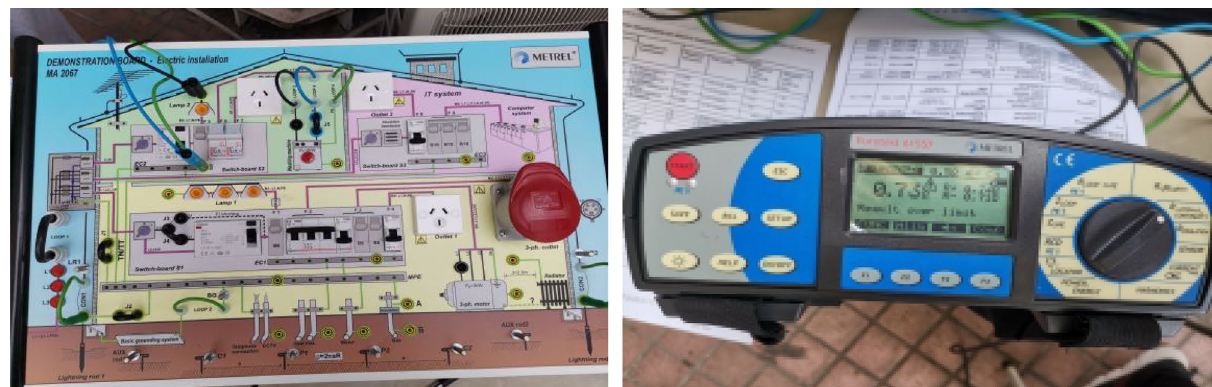
Figure 7. German Meicui MA2067 building electrical experimental platform (left) and Eurotest 61557 data acquisition device